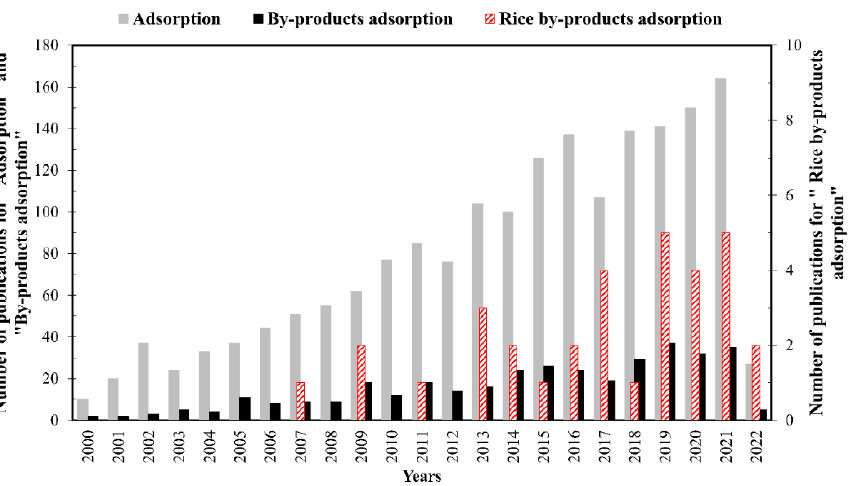
Figure 2. Number of publications per year from 2000 to 2022 searching on Scopus ® , for both arsenic and fluoride: (i) Adsorption (keywords: “adsorption AND drinking water”); (ii) By-products adsorption (keywords: “adsorption AND waste AND drinking water”); (iii) Rice by-products adsorption (keywords: “rice AND adsorption AND drinking water”).